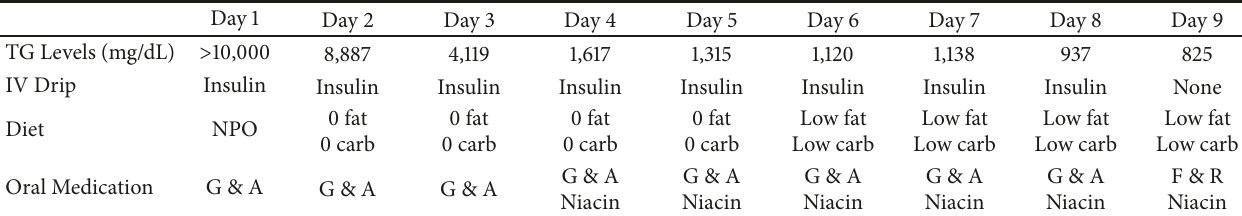
Table 1: Patient’s HTG trend along with therapies used and